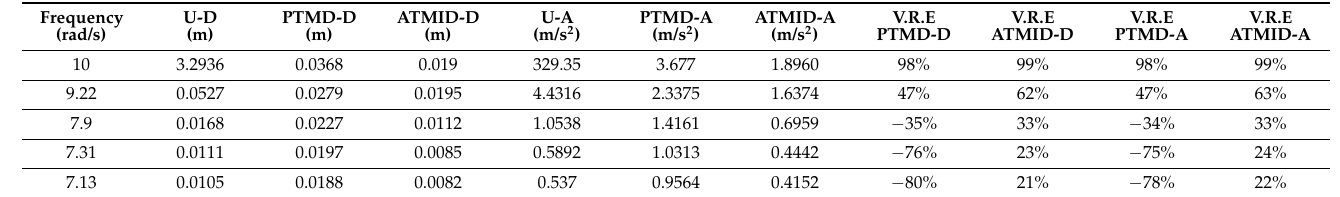
Figure 11. Structural maximum acceleration-maximum displacement in time-domain analysis at frequencies of 10 and 7.13 (rad/s). Table 4. Response structure in uncontrolled (U), PTMD-controlled and ATMID-controlled.